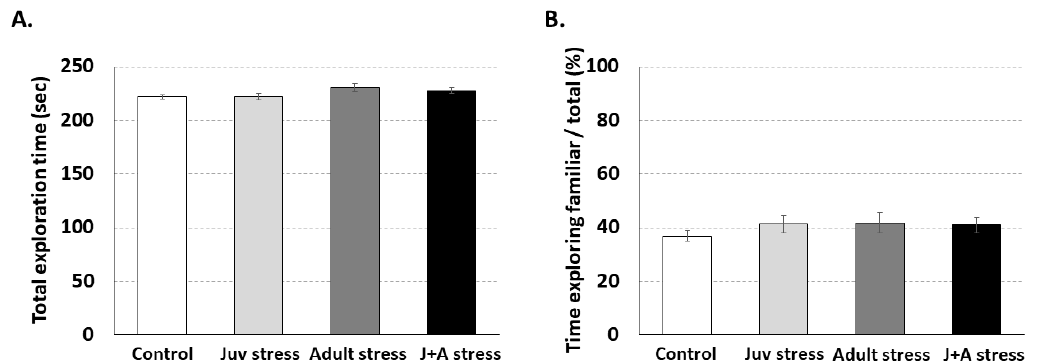
Figure 4. Social interaction test: No significant differences between the groups were found in total exploration time ( A ) and the amount of time spent exploring the familiar animal versus the unfamiliar animal ( B ).